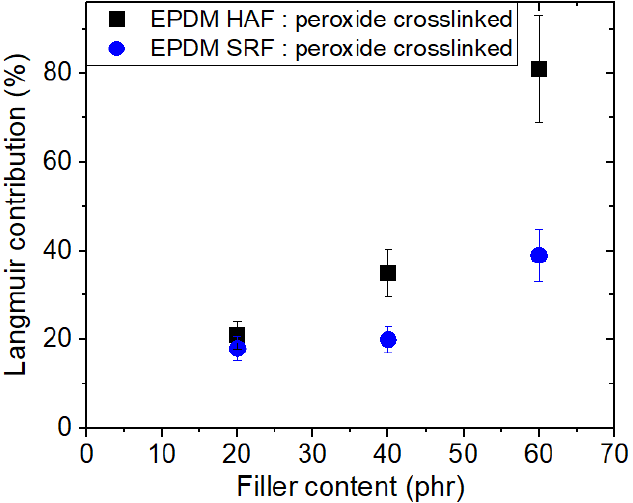
Figure 4. Langmuir contribution versus filler content for the CB ‐ filled EPDM composites.